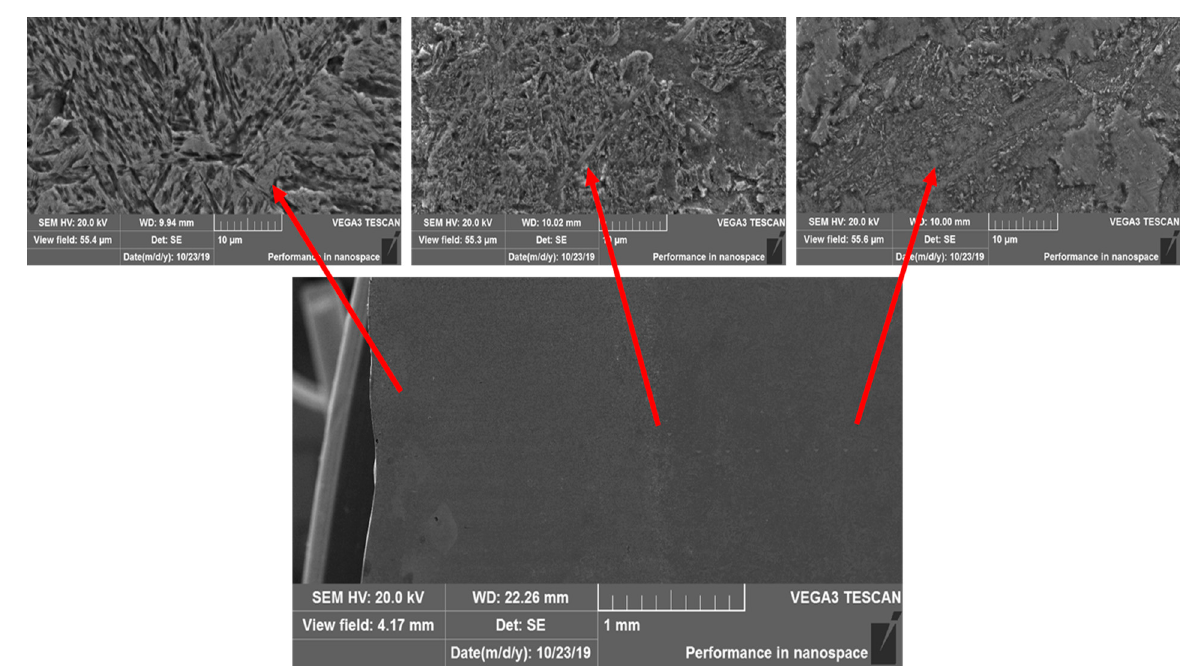
Figure 1. Microstructure of 0.34Cr-1Ni-Mo-Fe steel.